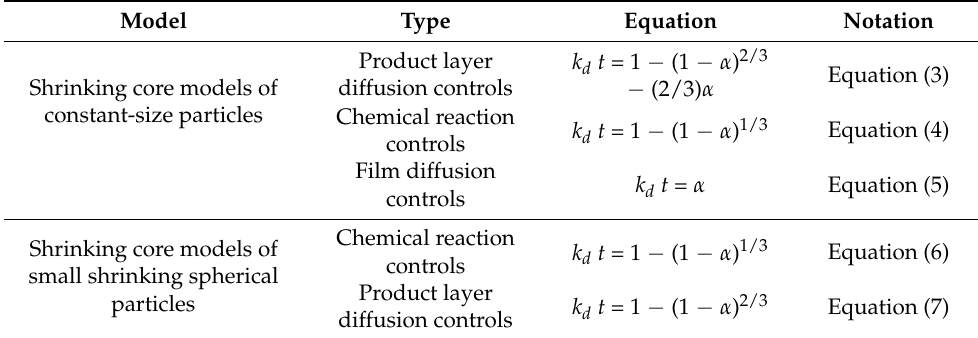
Figure 5. Schematic diagram of shrinking core models. Table 2. Classification of kinetic models.